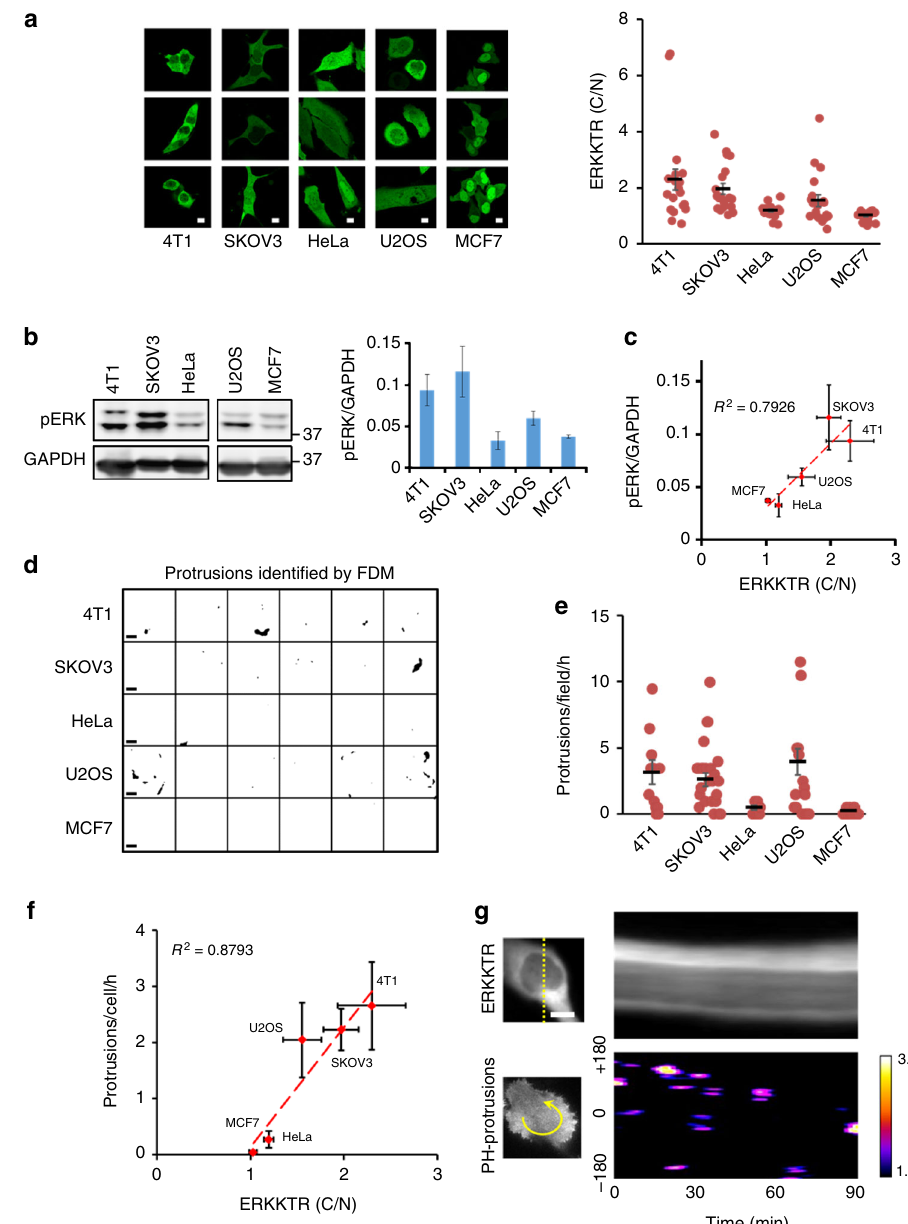
Fig. 2 Correlation between ERK activity and protrusion frequency across cell lines. a Representative confocal images of ERKKTR-GFP distribution and quanti fi cation of C/N ratio of ERKKTR (mean±s.e.m., n = 20 cells each) for fi ve different cell lines. b Immunoblot of phospho-ERK and GAPDH and quanti fi cation (mean intensity±s.e.m., n = 3 experiments; the upper and lower bands in pERK correspond to ERK1 and ERK2, respectively). c Correlation between phospho-ERK level and ERKKTR(C/N) across cell lines. d , e Identi fi cation and quanti fi cation of protrusions using FDM (Methods section) across cell lines. A snapshot of the FDM-processed image was shown ( d ) (see Supplementary Movie 8), along with quanti fi cation of the protrusion frequency ( e ) ( n = 13, 33, 9, 22, 48 cells for 4T1, SKOV3, HeLa, U2OS, MCF7, respectively). f Correlation between protrusion frequency and ERK activity across cell lines. g Kymographs of ERKKTR (upper) and PH-AKT-enriched protrusions (lower, color scale: intensity (A.U.) identi fi ed by FDM, see Methods) in an SKOV3 cell showing persistent nuclear exclusion of ERKKTR throughout the imaging period (corresponding to Supplementary Movie 9). Scale bars: 10 µ (Fig. 1d). The frequency of protrusions can be adjusted by changing the threshold of the excitable network. When the